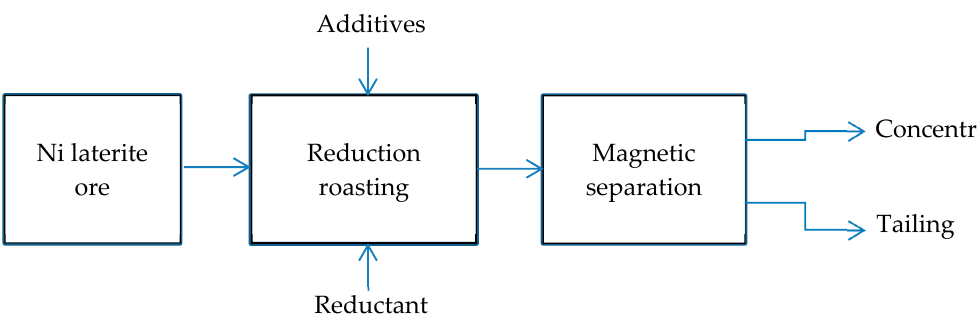
Figure 4. Flowsheet for the reduction roasting – magnetic separation process.